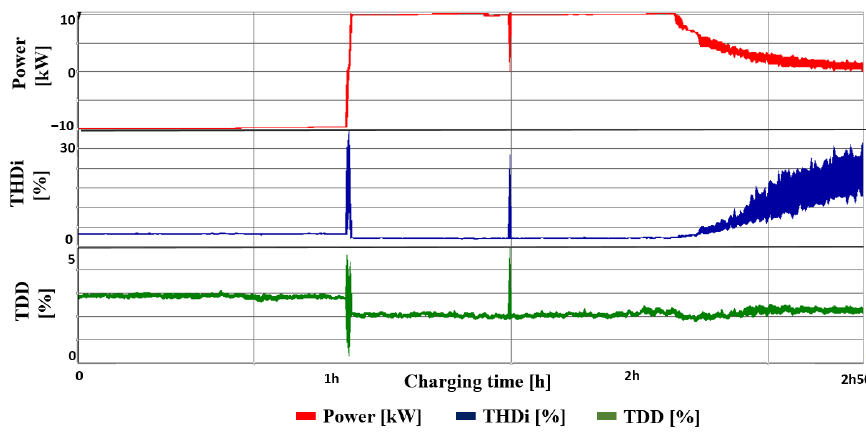
Figure 7. THD i and TDD during standard discharge and charge process [15].